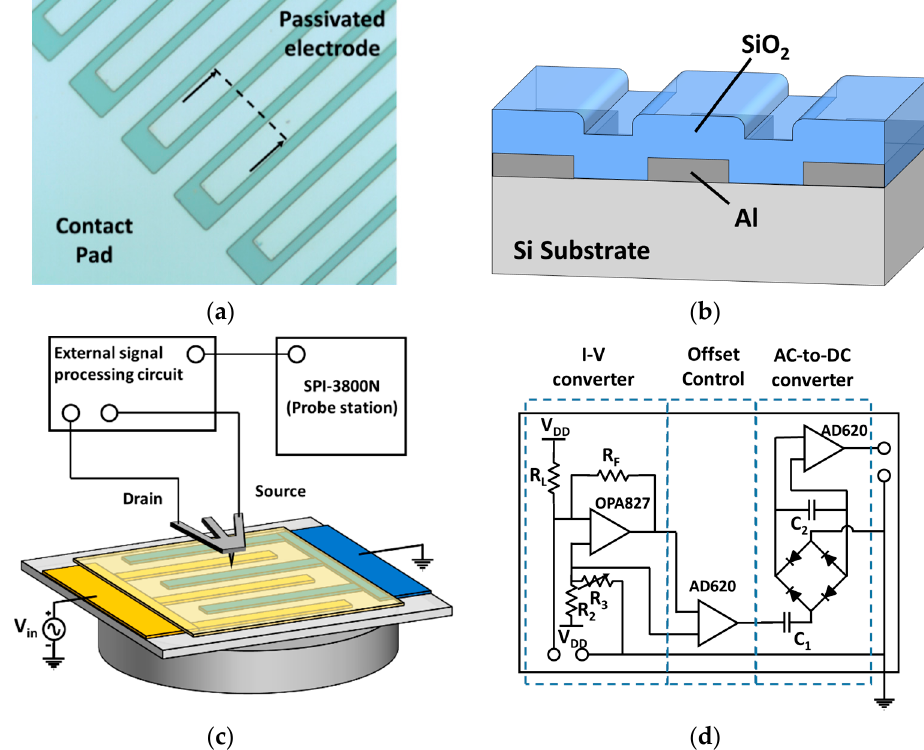
Figure 3. ( a ) Optical micrograph image of the interdigitated electrodes sample covered with SiO 2 and ( b ) its cross section; ( c ) Sshematic of the measurement setup of the probe; ( d ) the external signal processing circuit, including I-V converter, buffer, and AC-to-DC converter.